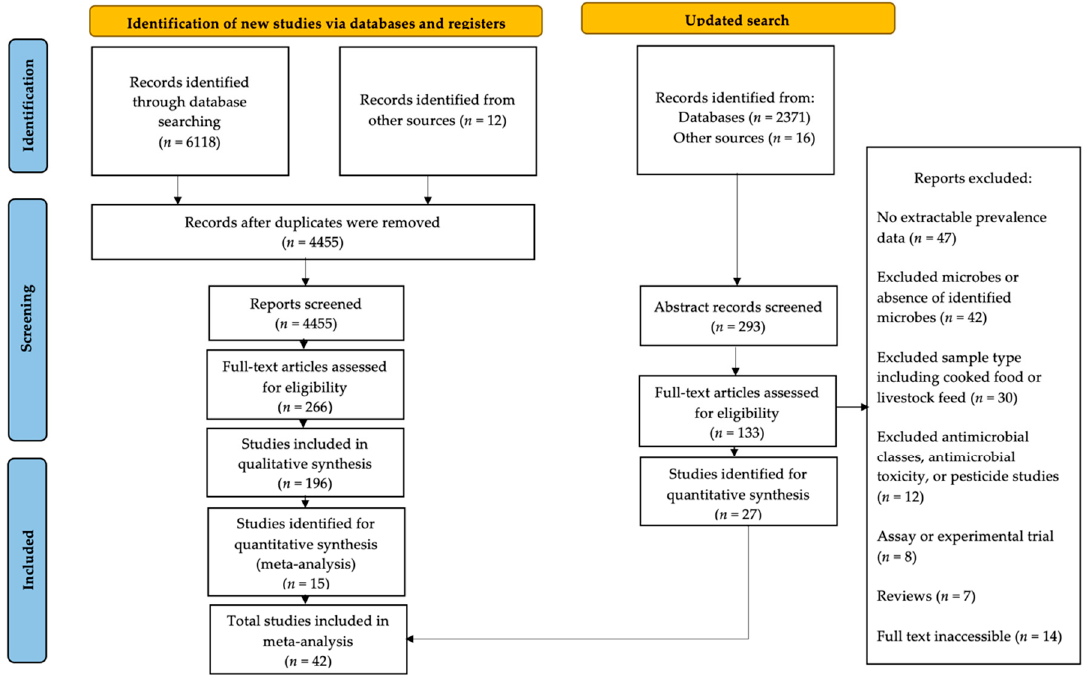
Figure 2. PRISMA Flow Chart: Adapted from Page et al. 2020 [32] (adapted under CC BY 4.0). All included studies were observational in design. Somewhat fewer prevalence estimates were extracted for phenotypic 3GC resistance ( n = 27), than for TET resistance ( n = 30) and the post-harvest stage of the value chain was the more common stage for sampling ( n = 43; pre-harvest stage: n = 18). Studies originated from 34 countries including all six world regions but favoured the Western Pacific Region ( n = 12), Europe ( n = 11), and Africa ( n = 8), with the fewest studies conducted in South East Asia ( n = 7), the Americas ( n = 4) and the Eastern Mediterranean region ( n = 4).